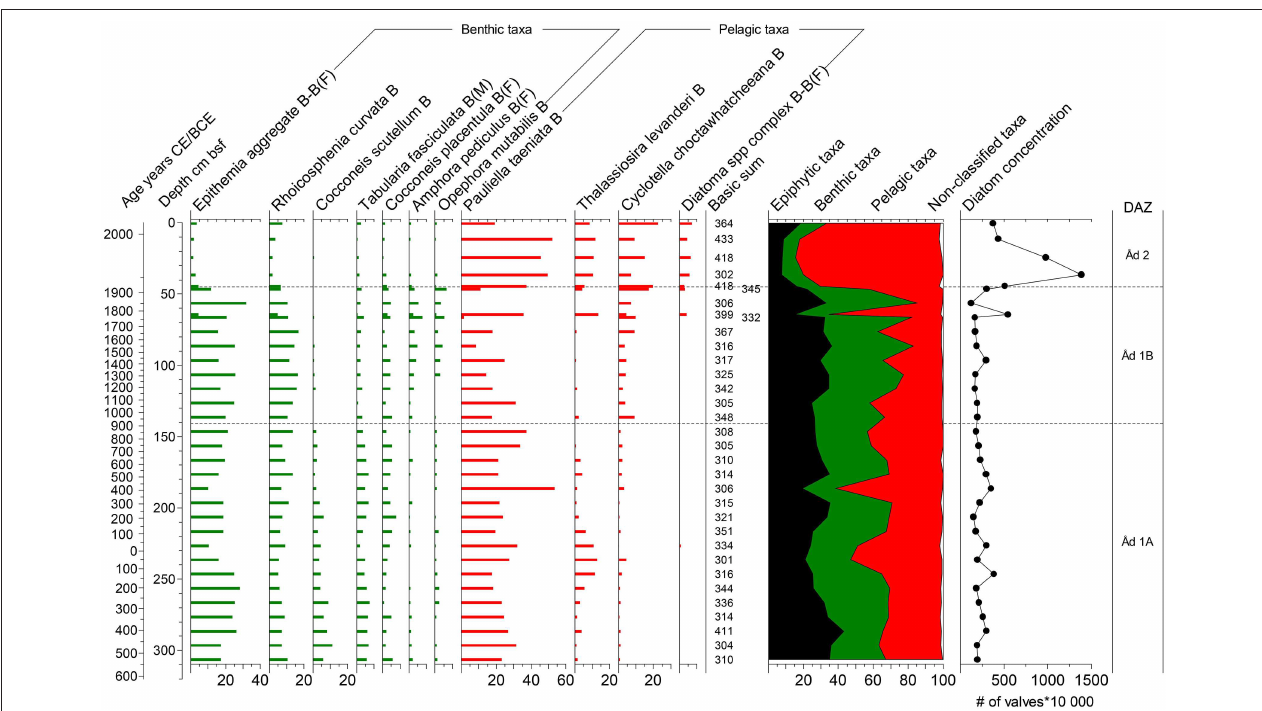
FIGURE 7 | Diatom diagram for the site Ådfjärden. For details see legend to Figure 5.